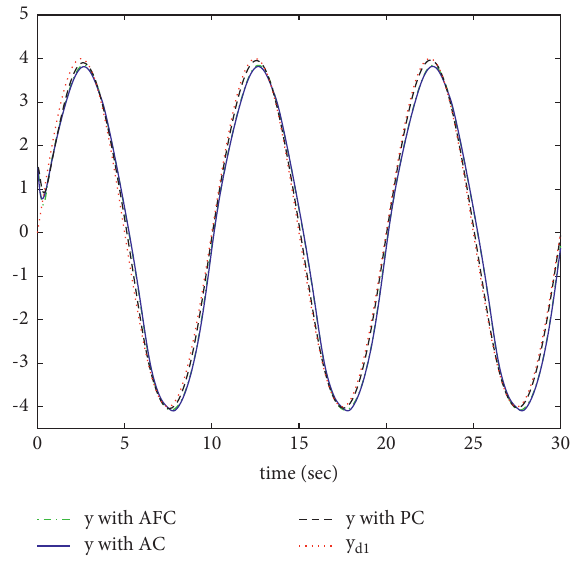
Figure 4: The trajectories with x